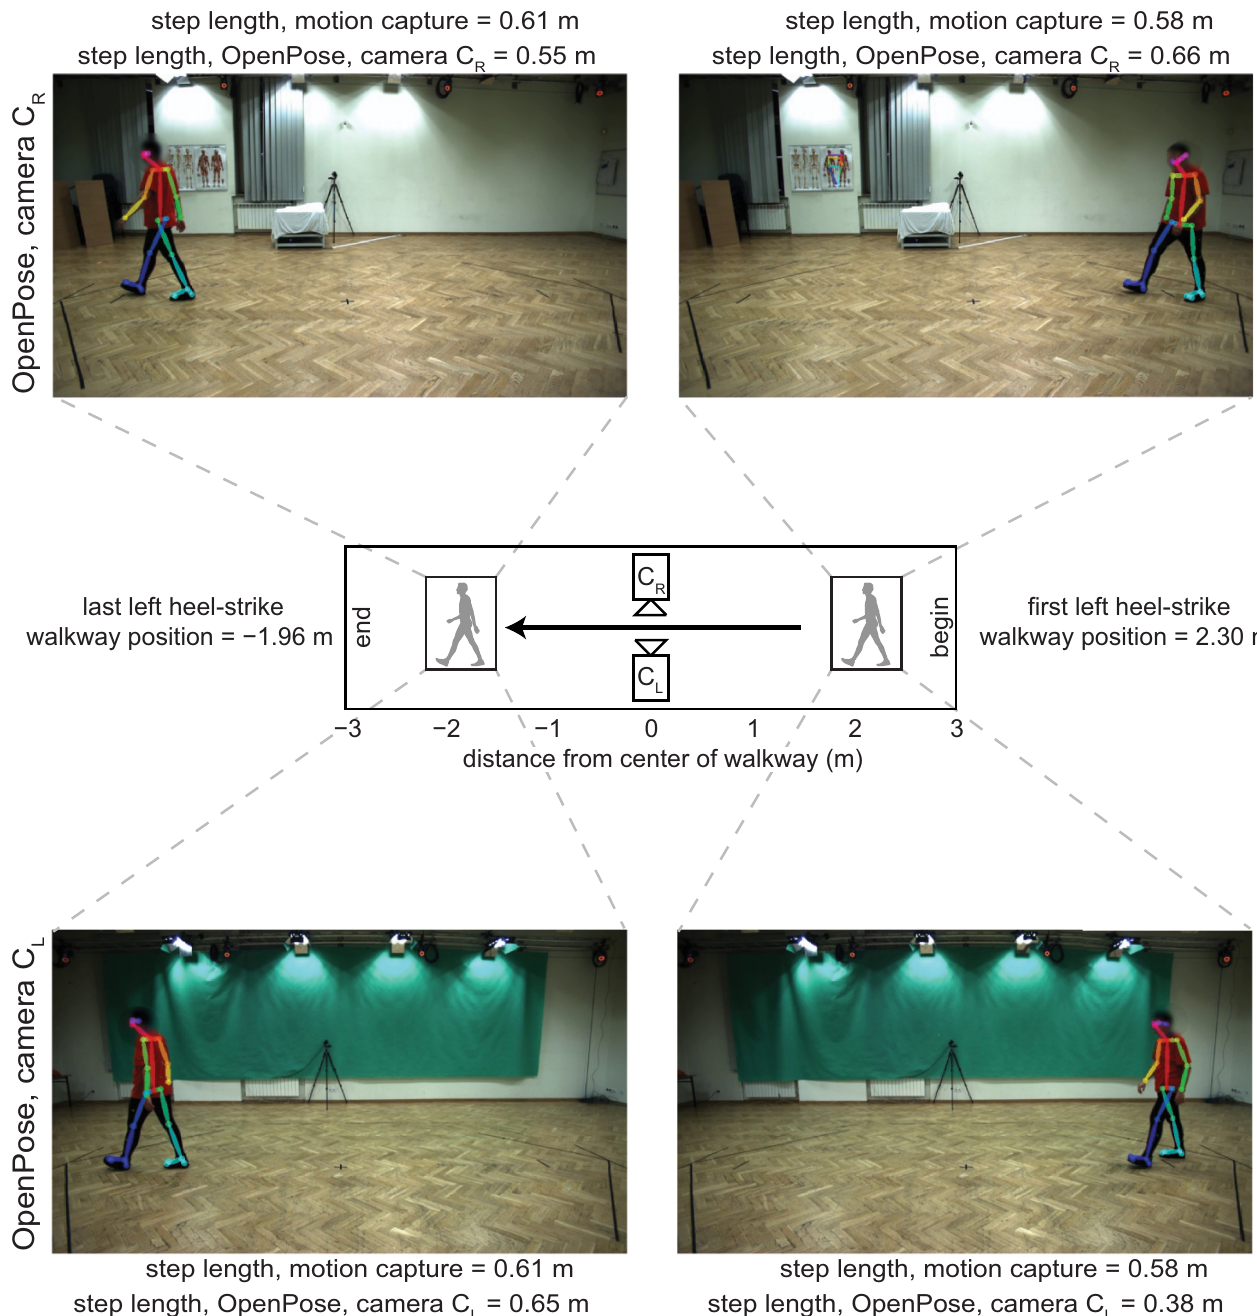
Fig 6. Example image frames of step length errors. Representative image frames taken from OpenPose output videos highlighting the discrepancies in step length calculation at different positions along the walkway and from different camera views. Note that images from camera C R are reflected across a vertical axis to make the walking direction consistent across camera views. The public dataset [18] from which the images belong is made available at http://bytom.pja.edu.pl/ projekty/hm-gpjatk/. See Release Agreement for copyrights and permissions.